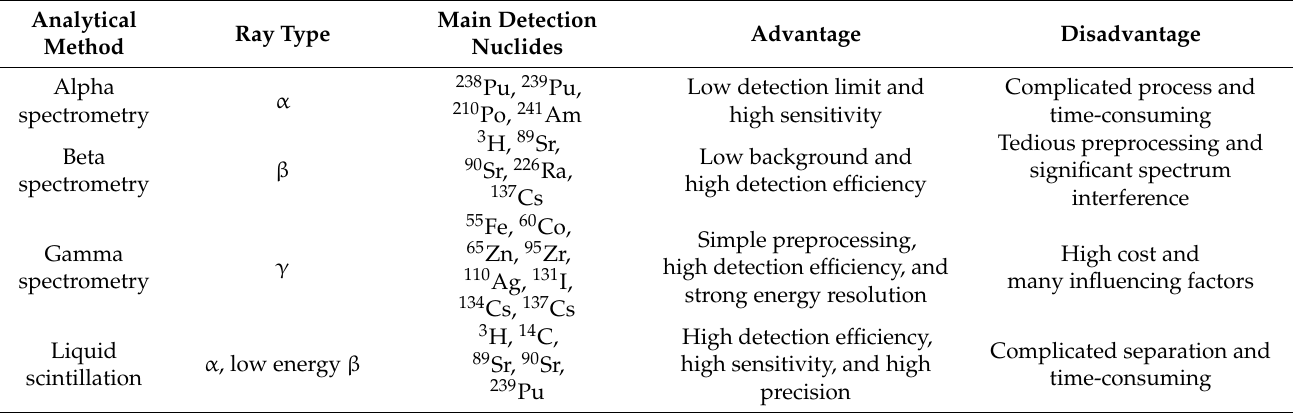
Table 5. Main radioactive detection methods of radionuclides in environmental samples.